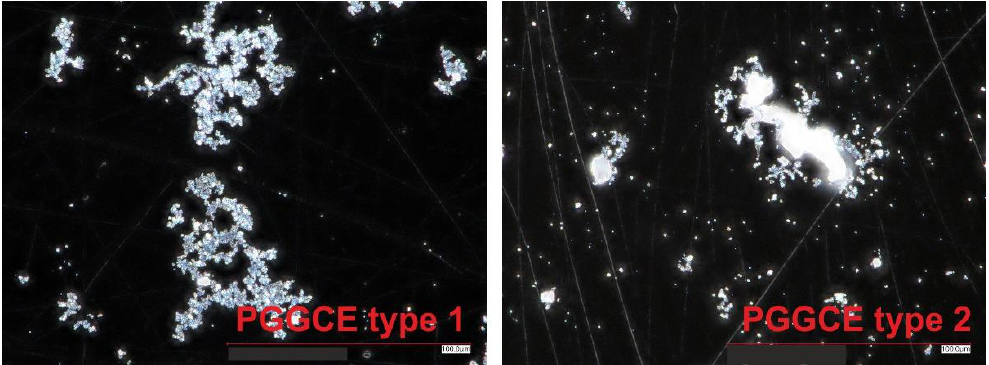
Figure 8. The images illustrating the blue surface modification of the universal PGGCE sensors were performed with an E500: ×1500 lens to stoichiometric detection of pyrazine drugs ( PZA and BZM